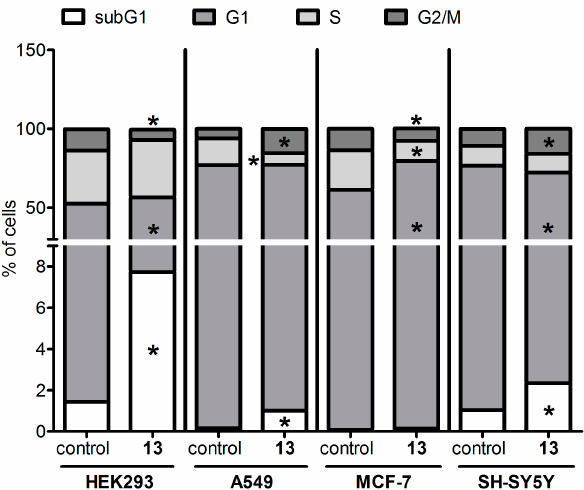
Figure 2. Cell cycle progression of HEK293, A549, MCF-7, and SHSY5Y cells upon compound 29 treatment. Data are expressed as mean ± S.E.M from three experiments, performed in triplicate. *— p ˂ 0.05 vs. corresponding control (untreated) cells (Wilcoxon t -test); **— p ˂ 0.01 vs. corresponding control (untreated) cells (Wilcoxon t -test).